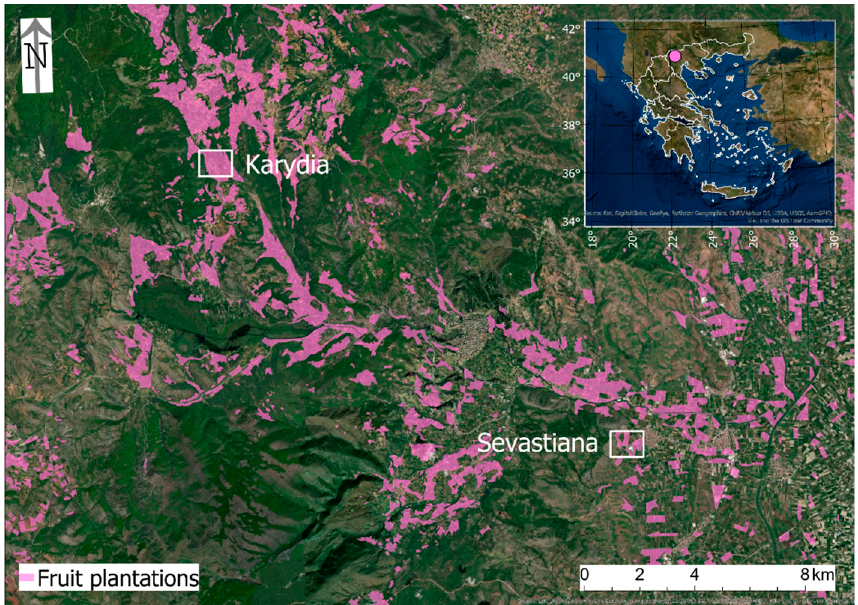
Figure 1. The location of the study area and the two study sites of the cherry plantations.